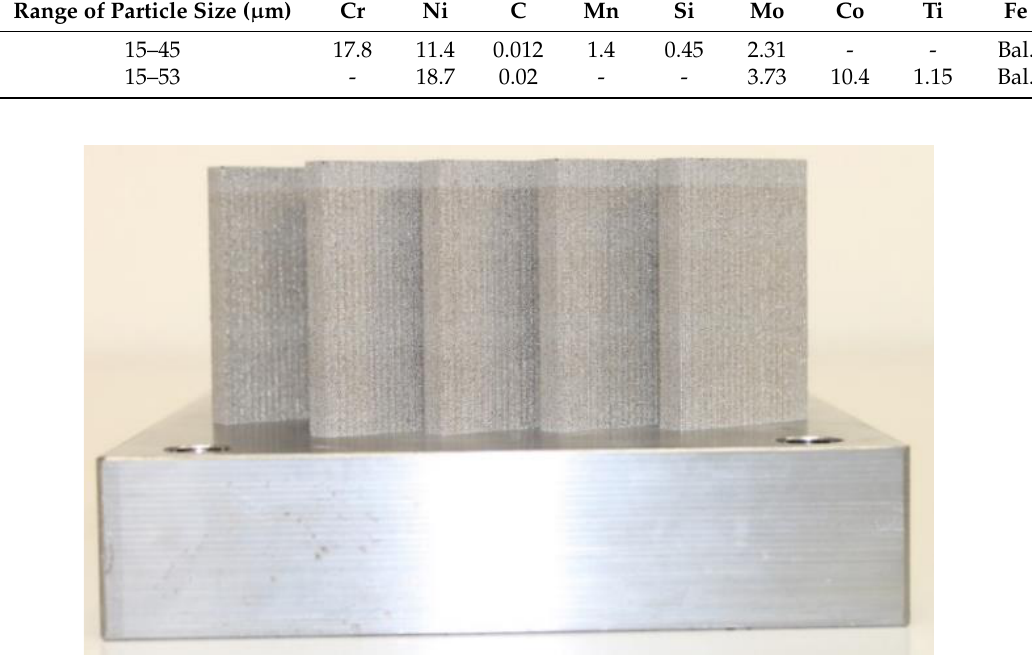
Figure 2. Metal powder morphology displayed by scanning electron microscopy. ( a ) 18Ni (300) — coating, ( b ) AISI 316L — substrate.